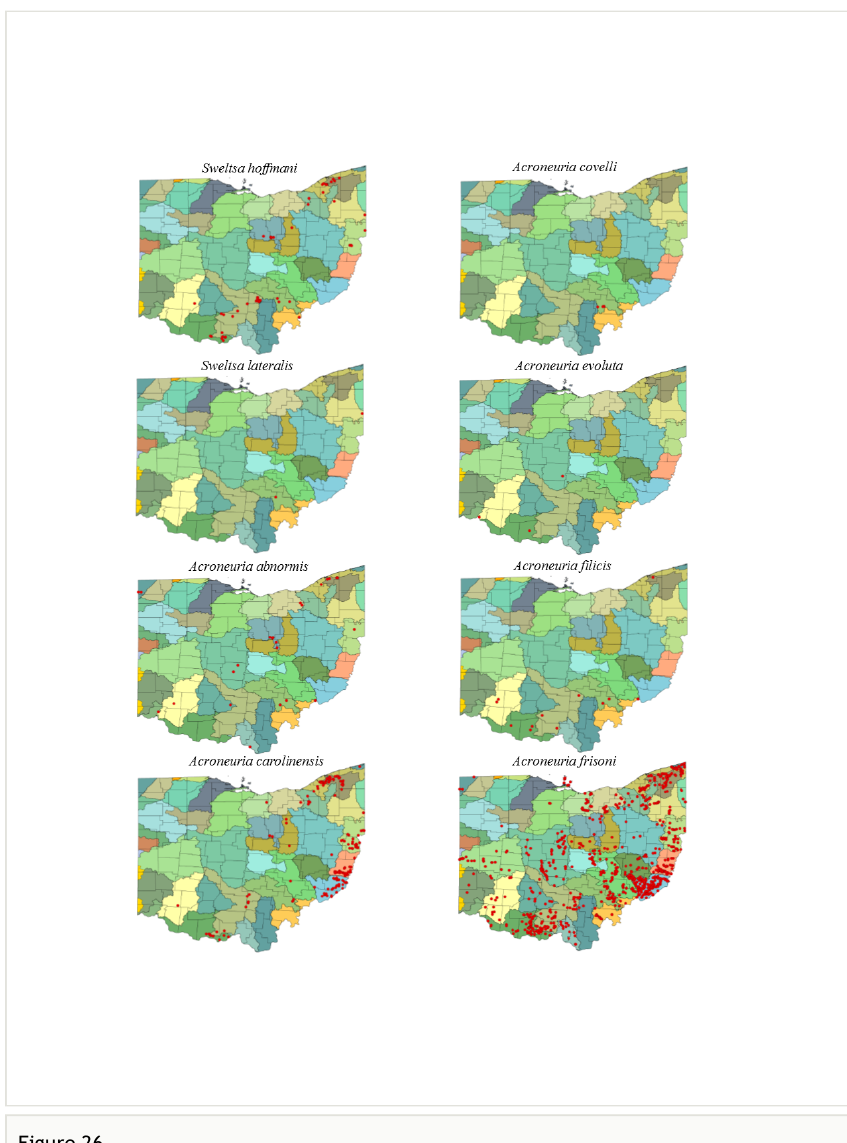
Figure 26. Distribution of Chloroperlidae and Perlidae in